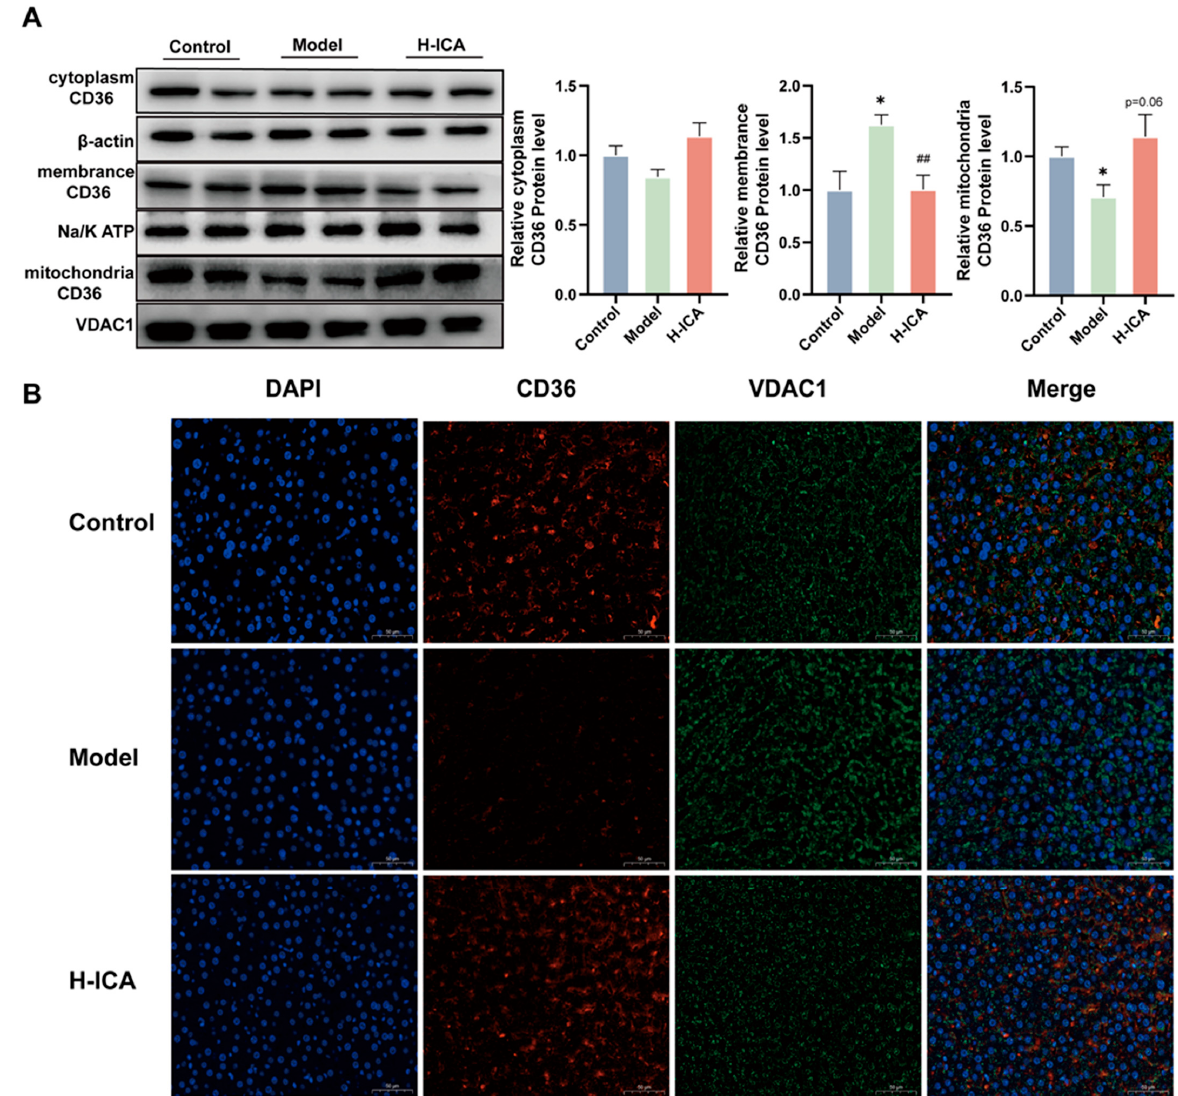
Figure 5. Icariin alleviates NAFLD in PCOS by increasing CD36 content in mitochondria. The protein levels of CD36 in the cytoplasm ( β -actin as an internal reference), cell membrane (Na/K ATP as an internal reference) and mitochondria (VDAC1 as an internal reference) were analyzed separately. n = 6 ( A ). CD36 and VDAC1 double immunofluorescence staining in liver tissue (scale bar = 50 µ m, n = 3), green fluorescence indicated the mitochondrial marker VDAC1, red fluorescence indicated CD36 ( B ). values are mean ± SEM; Control vs. Model, * p < 0.05, Model vs. drug group ## p <